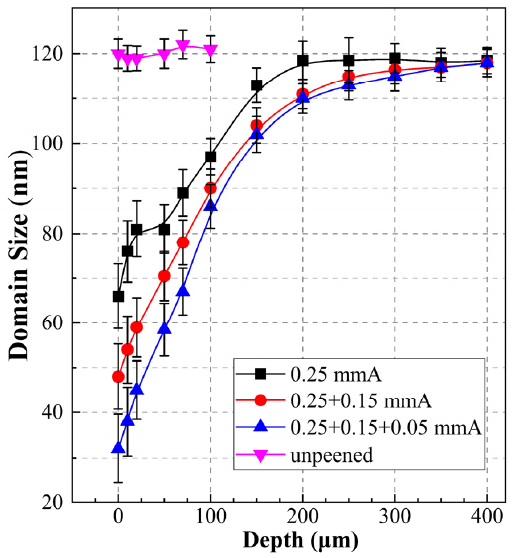
6 of 10 Figure 4. A typical X-ray pattern of CNTs/Al − Mg − Si alloy composite. As can be seen in Figure 5, after the peening treatment, the average domain sizes were refined significantly in the surface layer and ramp up until it is equal to the substrate.